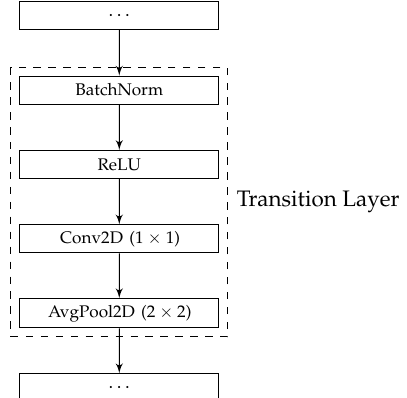
Figure 3. A Transition Layer in the SODBAE skeleton architecture (consisting of batch normalisation, ReLU, convolutional, and average pooling